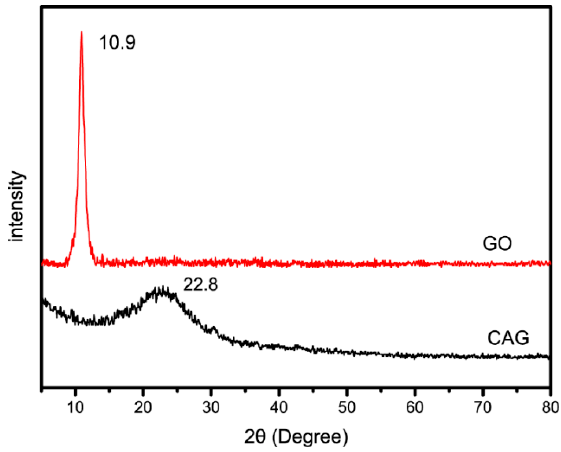
Figure 3. XRD spectra of CAG-GO20%.